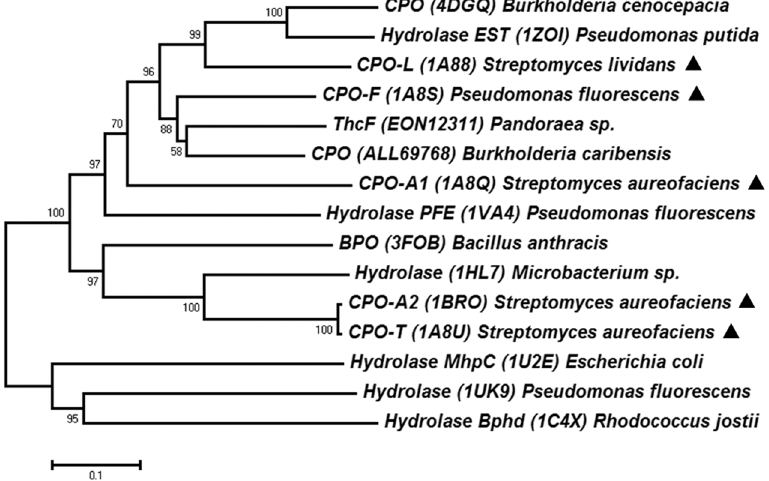
Fig 1. Evolutionary relationships between the cofactor-free HPO and the α / β hydrolases. The phylogenetic tree was reconstructed using the Neighbor-Joining method. The representative HPO enzymes are marked ( ▲